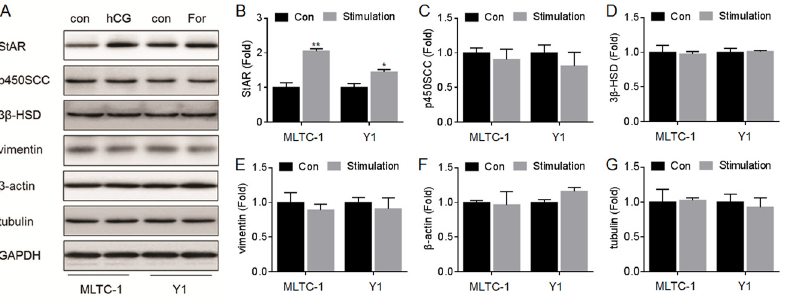
Fig 2. Effects of hCG/For on the expressions of StAR, p450scc, 3 β -HSD, vimentin, β -actin, and tubulin. MLTC-1 and Y1 cells were exposed to 100 U/L hCG or to 10 μ M forskolin for 24 h, respectively. (A) Western blots analysis and relative protein levels of (B) StAR, (C) p450SCC, (D) 3 β -HSD, (E) vimentin, (F) β - actin, and (G) tubulin. * p < 0.05 and ** p < 0.01 compared with medium control cells.